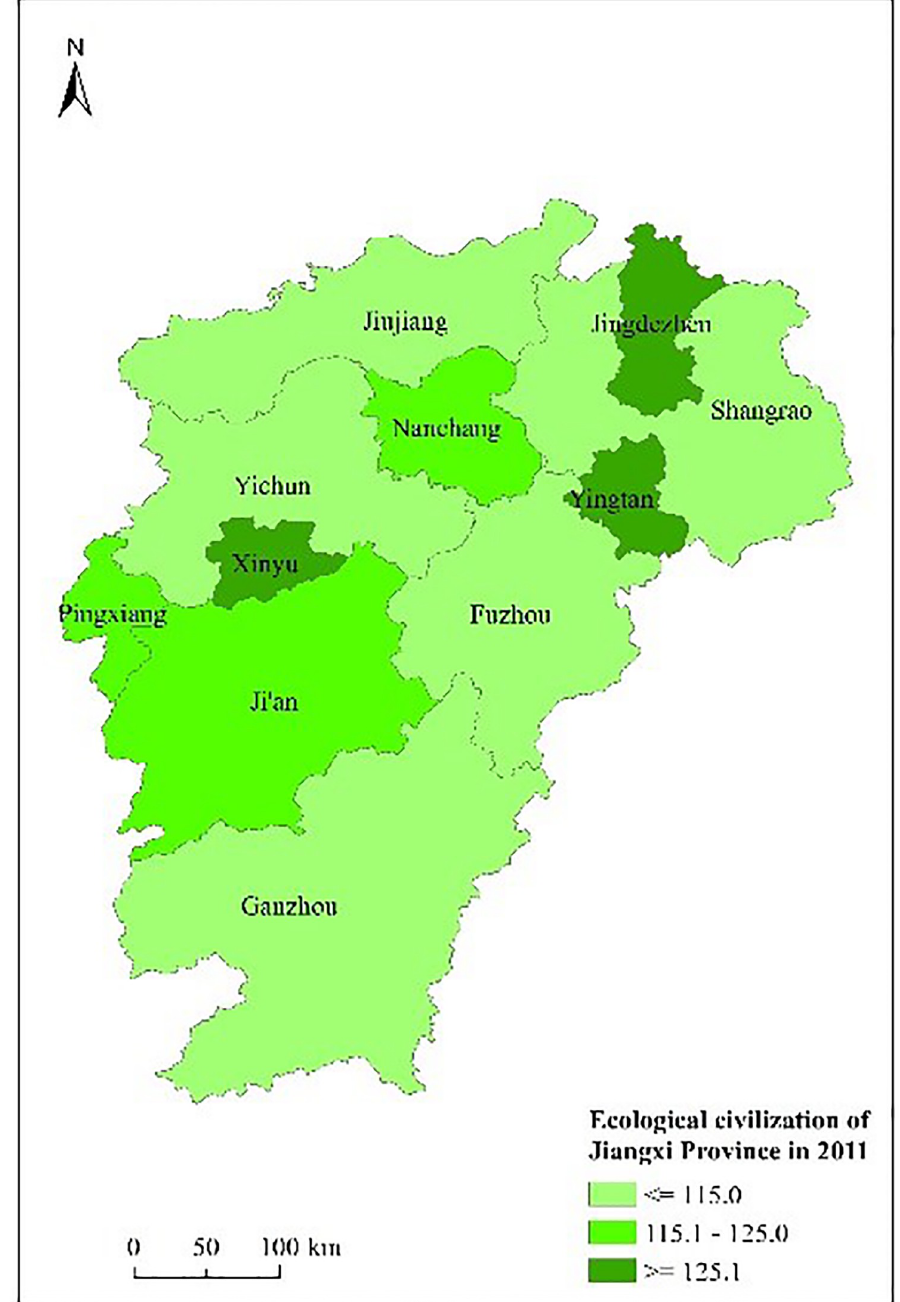
Fig 4. Space distribution of ecological civilization of Jiangxi Province (base map and data from OpenStreetMap and OpenStreetMap foundation. Contains information from OpenStreetMap and OpenStreetMap foundation, which is made available under the Open Database license. Data source comes from Table 4). Source: Republished from Jiangxi Provincial Bureau of Statistics under a CC BY license, with permission from China Statistics Press, original copyright 2010 to